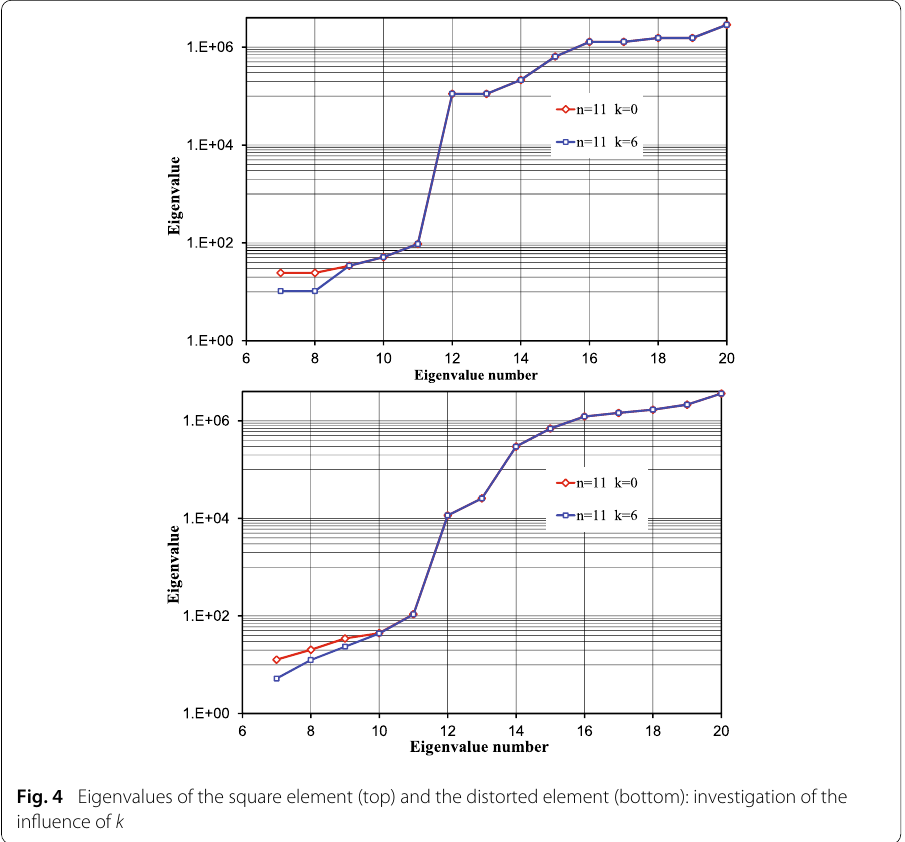
Fig. 4 Eigenvalues of the square element (top) and the distorted element (bottom): investigation of the influence of k